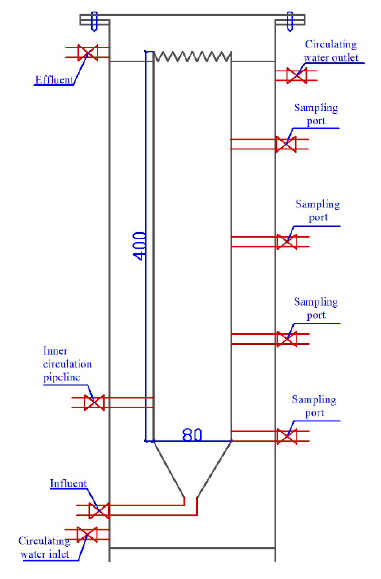
Figure 2. Graphic scheme of the reactor.